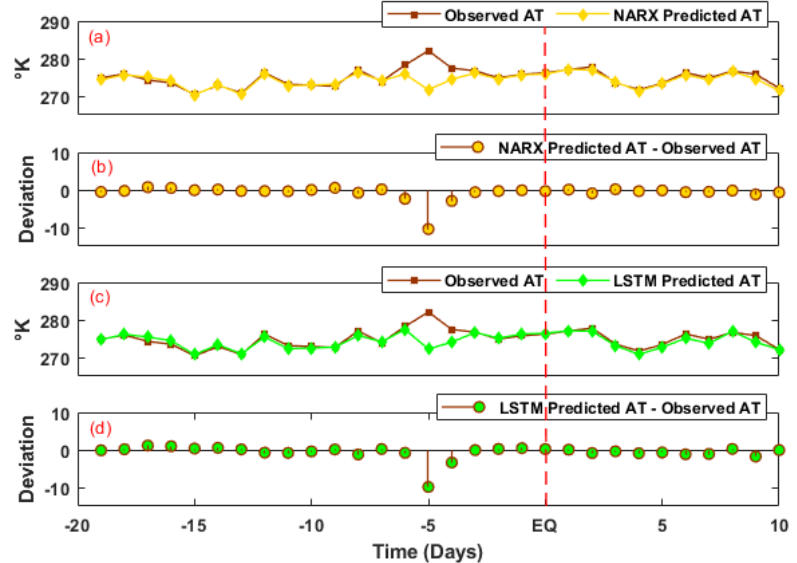
Figure 7. ( a ) Variations between the observed AT data and NARX-predicted AT values, ( b ) Deviation of NARX-predicted AT values from Observed AT values, ( c ) Variations between observed AT values and LSTM train AT values, ( d ) Deviation of LSTM-predicted AT values from Observed AT data. The red dashed line shows the earthquake day.